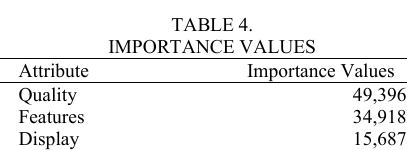
TABLE 4. IMPORTANCE